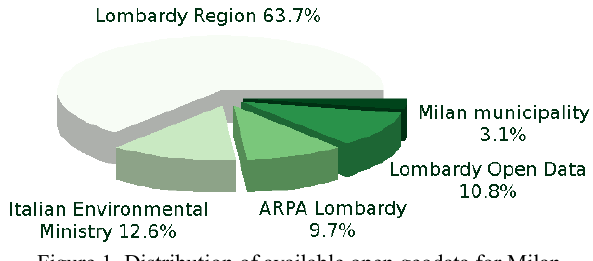
Figure 1. Distribution of available open geodata for Milan Municipality according to their